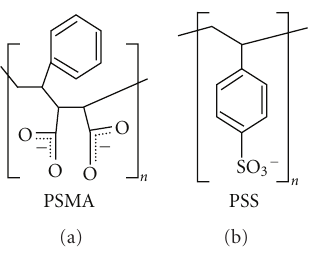
Figure 1: Structures of alt -PSMA and PSS. (a) alt -PSMA (120,000 average MW) is a readily synthesized copolymer of styrene and maleic acid that incorporates two carboxylic groups and a phenyl group in each repeating unit. (b) The structure of poly(sodium 4- styrene sulfonate) (PSS), which includes a single, sulfated phenyl ring in each repeat unit, is shown for